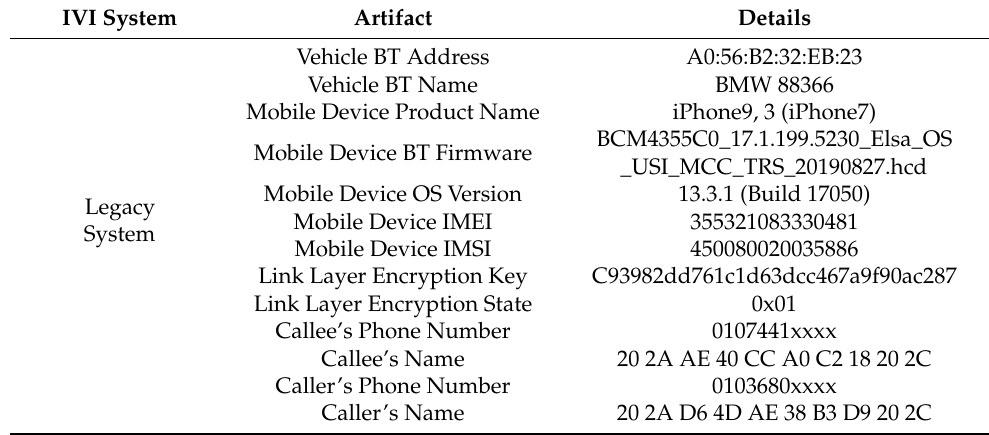
Table 5. List of Artifacts in Wireless Communication between the IVI and Mobile Device (Legacy